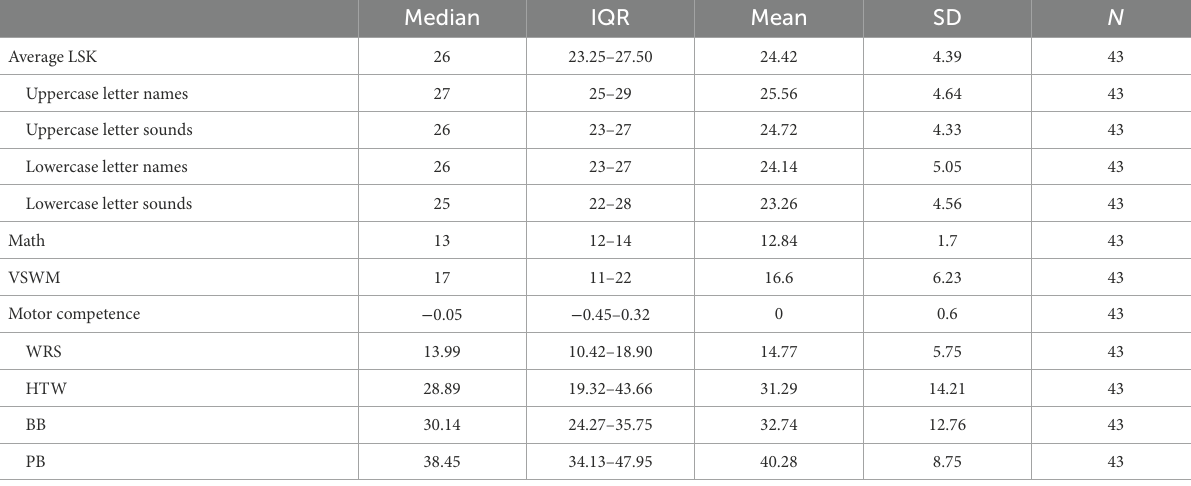
TABLE 2 Descriptive statistics of LSK, math competence, VSWM, and motor competence in first graders for males.